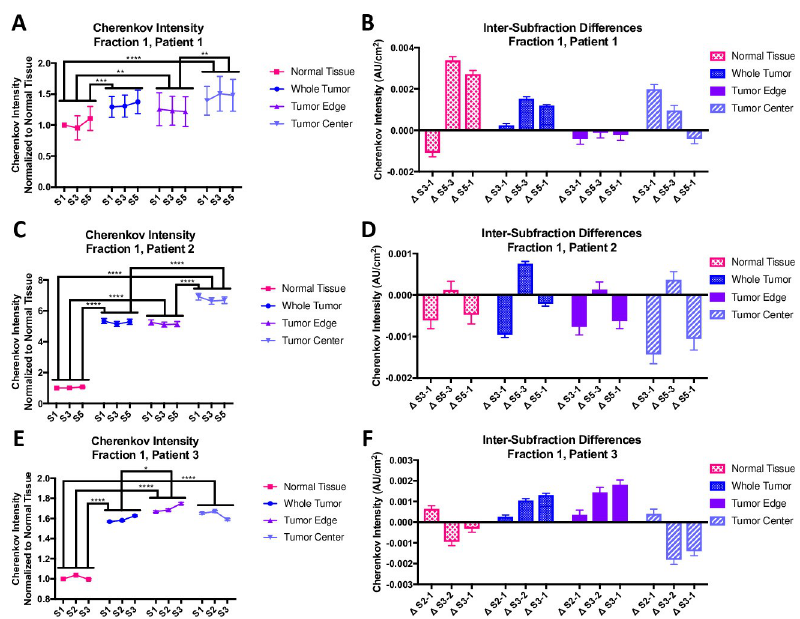
Fig 5. First fraction data for three canine subjects. The Cherenkov intensity data (A, C, E) has been normalized to the first normal tissue subfraction. The intensity for the whole tumor, normal tissue, tumor edge and tumor center is shown, all for the same gantry angle. Using a one-way ANOVA that compared all groups followed by Tukey’s multiple comparisons test, normal tissue is consistently different than the remainder of the tumor areas, as is the tumor edge ( � p < 0.05, �� p < 0.01, ��� p < 0.001, ���� p < 0.0001). The intensity difference between the adjacent subfractions as well as the difference between the first and last subfractions are shown (B, D, F). No significant difference between Δ S X2 -S X1 was found nor are there any trends in the data. A) Normalized Cherenkov intensity for canine 1, fraction 1 B) Inter- subfraction difference for canine subject 1, fraction 1 C) Normalized Cherenkov intensity for canine subject 2, fraction